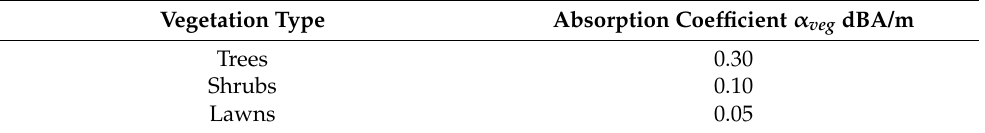
Table 2. Noise absorption by different vegetation